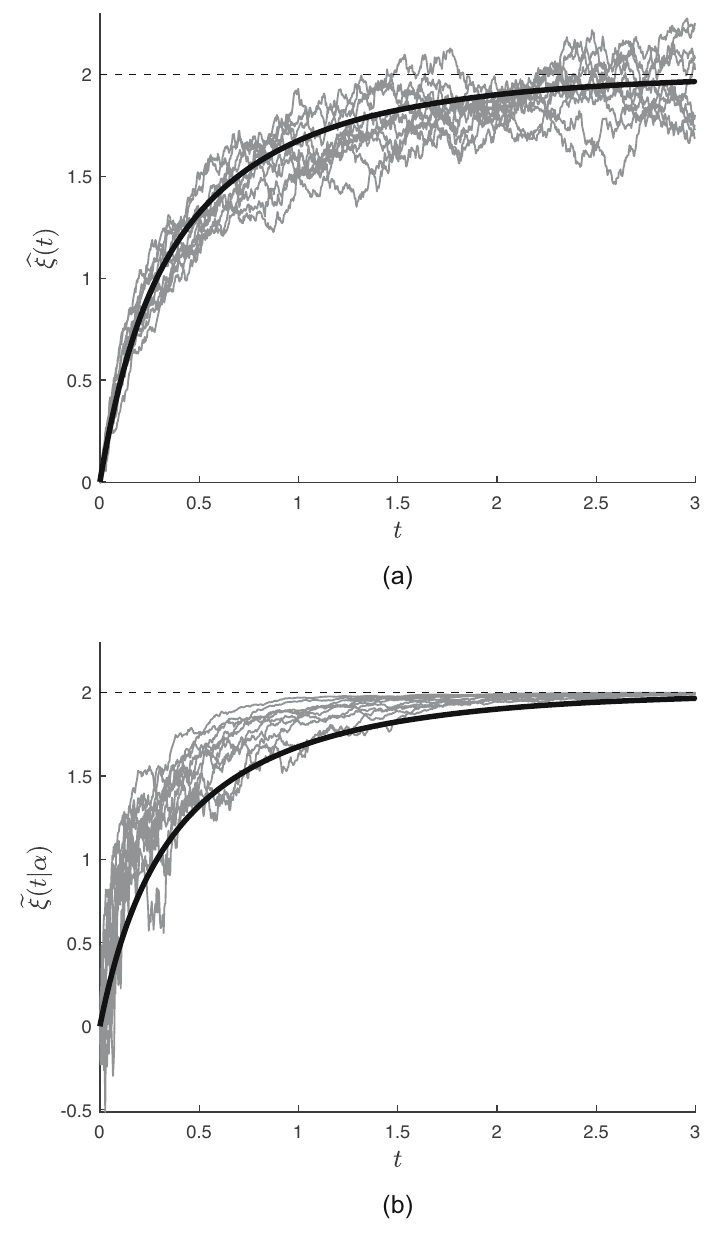
Figure 1: The randomized solution  ( ) ξ t of the Riccati equation ( a ) and the solution ( ∣ )͠ ξ t α of the stochastic Riccati equation ( b ) . Parameters of the Riccati equation are set to = = = δ y y 1, 2, 3 ; the initial conditions are set to zero at = t 0 . The scaling 1 2 variable ε is set to 5 in ( a ) ; α is set to 0.5 in ( b ) . Thin grey lines denote randomized and stochastic solution trajectories in ( a ) and ( b ) , respectively. Thick black lines depict the solution of the deterministic Riccati equation. The dashed black line denotes the upper bound for the deterministic solution for > t 0